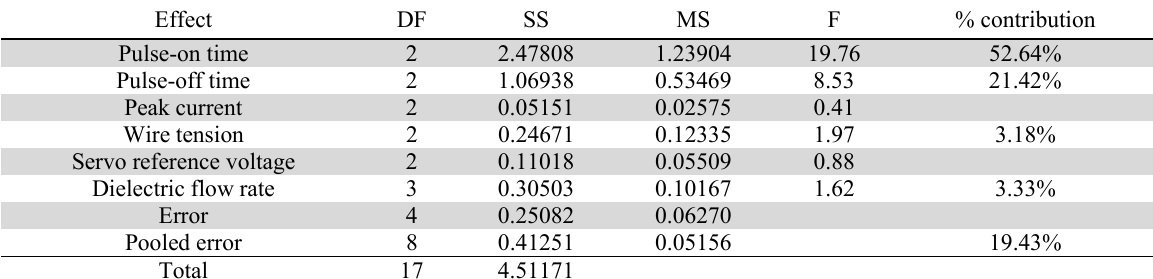
Fig. 8. Decision tree for machining speed (three classes) ANOVA results for machining speed